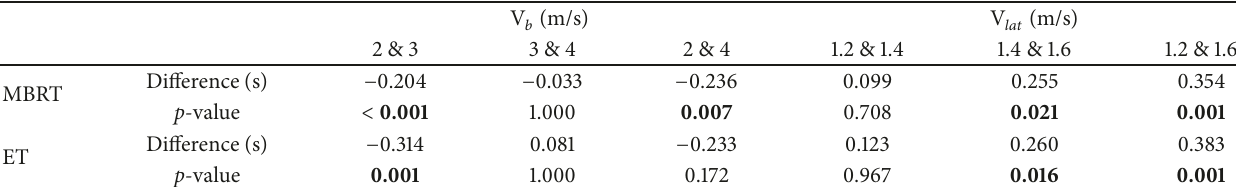
Figure 12: The average ( ± SD) of MBRT, ET, and BRT at three levels of the four parameters in SCR. Table 11: Post hoc analysis for MBRT and ET in SSR.